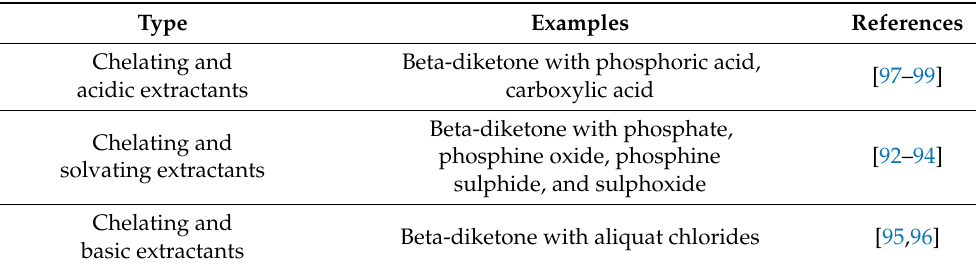
Table 2. Some potential approaches for synergistic scandium extraction using chelating extractant mixtures.